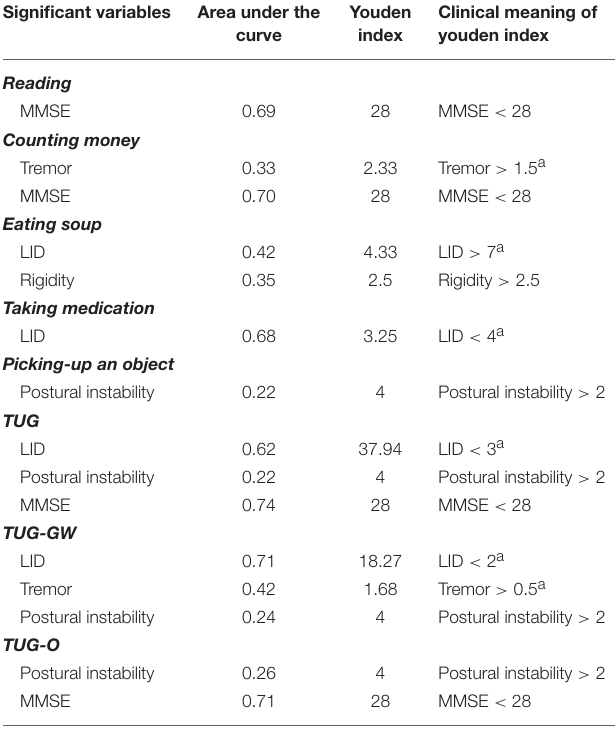
TABLE 3 | Critical values of symptoms at which the performance becomes